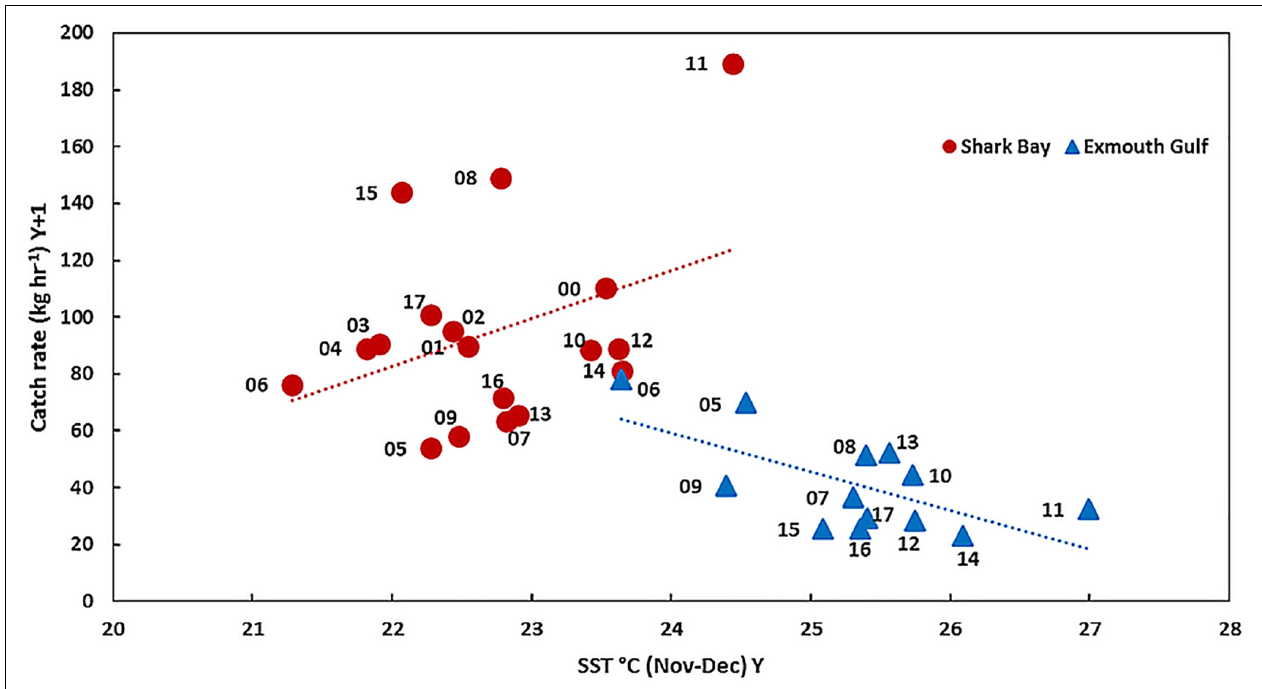
FIGURE 10 | The relationship between western king prawn recruitment abundance in March–April (year Y + 1) and SST during November–December in the previous year (Y) in Shark Bay and Exmouth Gulf. The recruitment year is